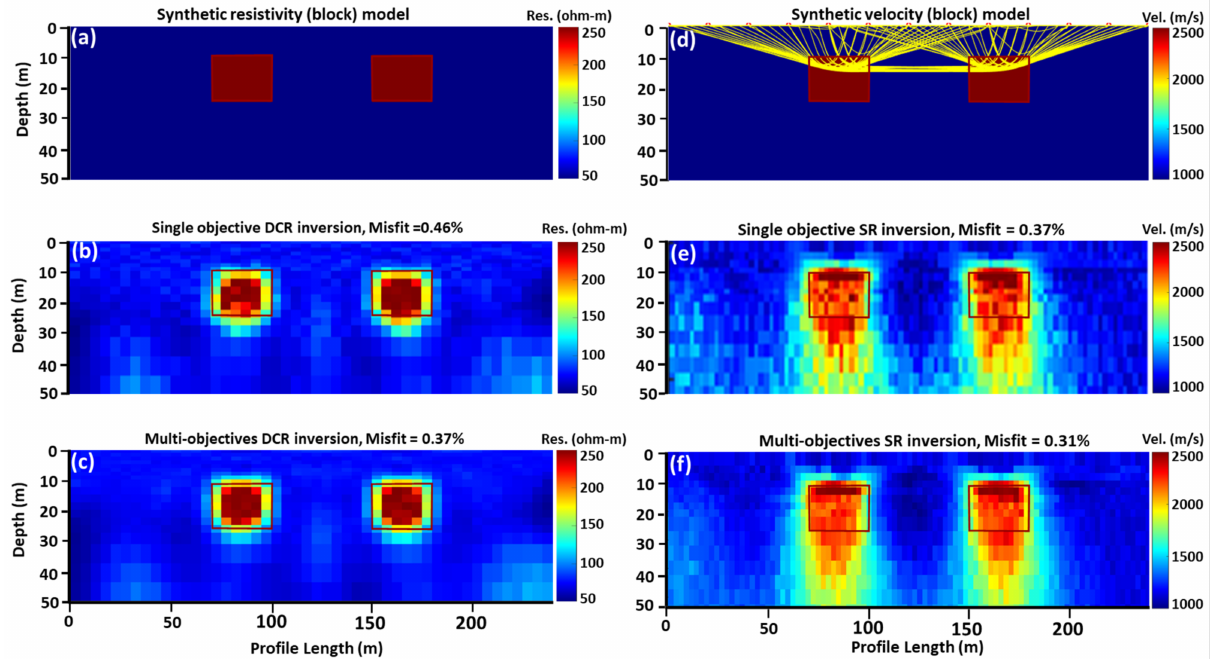
Figure 8. Positive anomaly model inversion using combined optimization method; ( a ) synthetic dc-resistivity model, ( b ) single objective inverted resistivity model, ( c ) multi-objective inverted resistivity model, ( d ) synthetic velocity model and its ray path coverage, ( e ) single objective inverted velocity model, and ( f ) multi-objective inverted velocity model. The dark red line is used to mark the anomaly